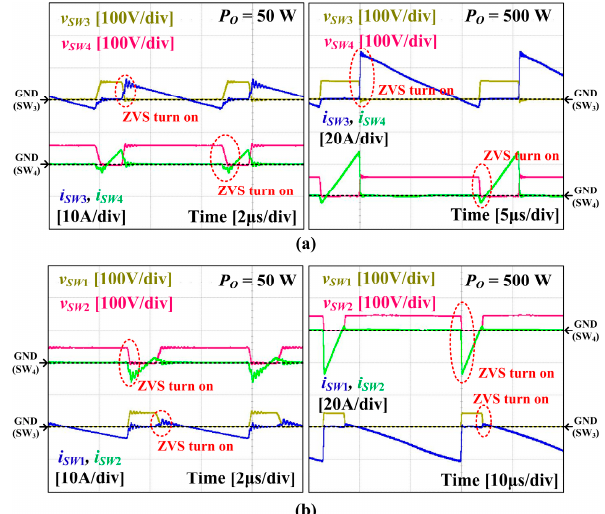
Figure 15. Voltage and current waveforms of switches measured at V a = 48 V and P b = 50 W and 500 W: ( a ) V b = 60 V and ( b ) V b = 36